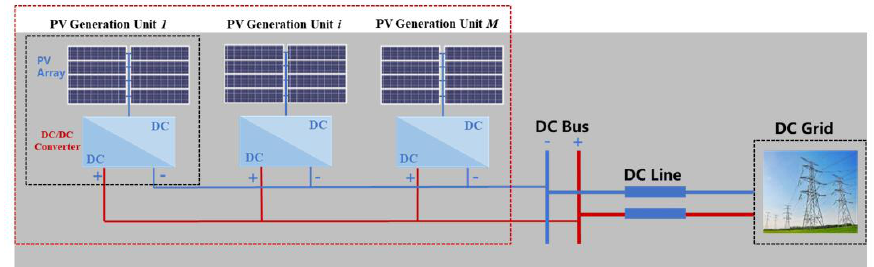
Figure 2. Structure of PV power plant collection and connected to DC grid with DC/DC